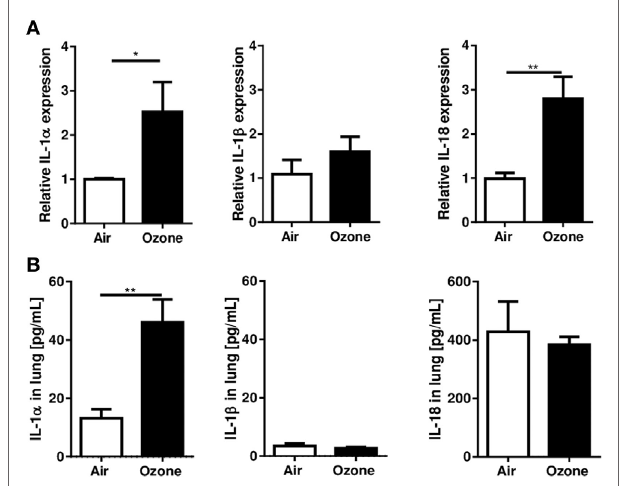
FigUre 1 | Interleukin (IL-1) α , IL-1 β , and IL-18 expression in the lung 24 h after ozone exposure. Expression of IL-1 α , IL-1 β , and IL-18 mRNA (a) and protein (B) in lung of wild type mice, 24 h after single ozone exposure (1 ppm during 1 h). Representative data of two-independent experiments are shown. Results are expressed as mean ± SEM and are from one experiment with n = 4–6. Statistical test: Mann–Whitney, p value: * <